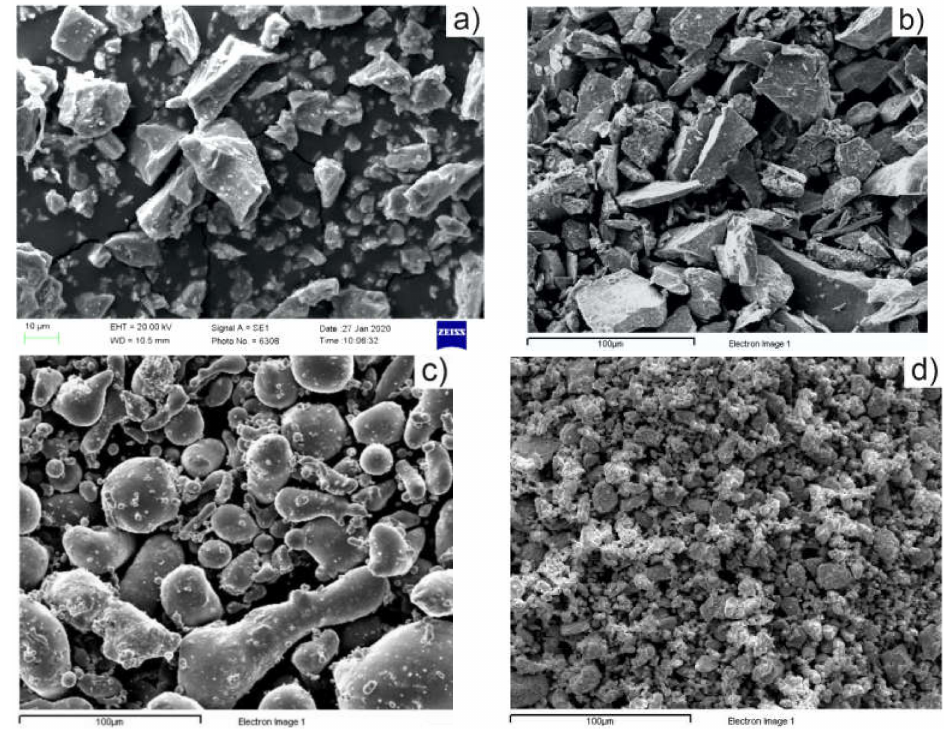
Figure 2. Scanning electron microscopy (SEM) images of: ( a ) TiH 2 powder, ( b ) Mn powder; ( c ) Sn powder; ( d ) Zr powder.